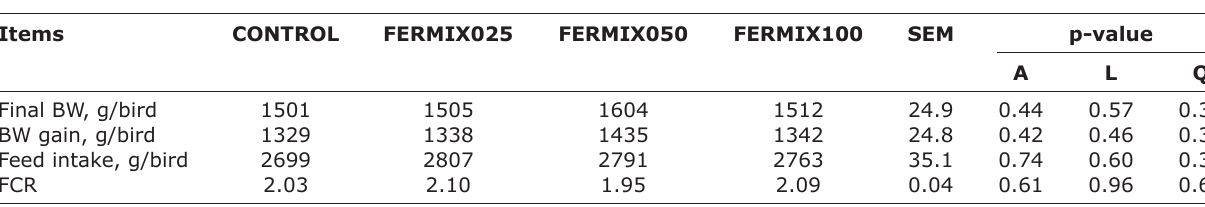
Table-2: Growth performance of broiler chickens.